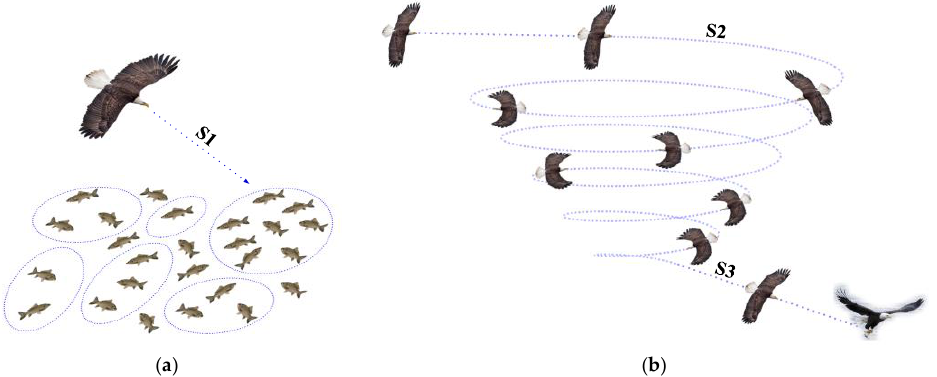
Figure 2. Diagram of the BES for the three main phases of hunting (S1 — selecting phase; S2 — searching phase; S3 — swooping phase). ( a ) Selecting phase; ( b ) Search and swooping phase.